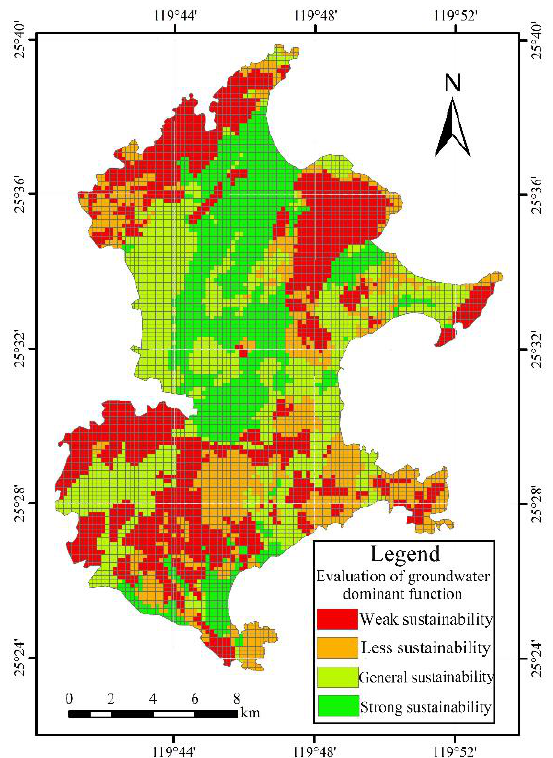
Figure 8. Distribution of comprehensive evaluation index of dominant function of shallow ground- water in the study area. water in the study